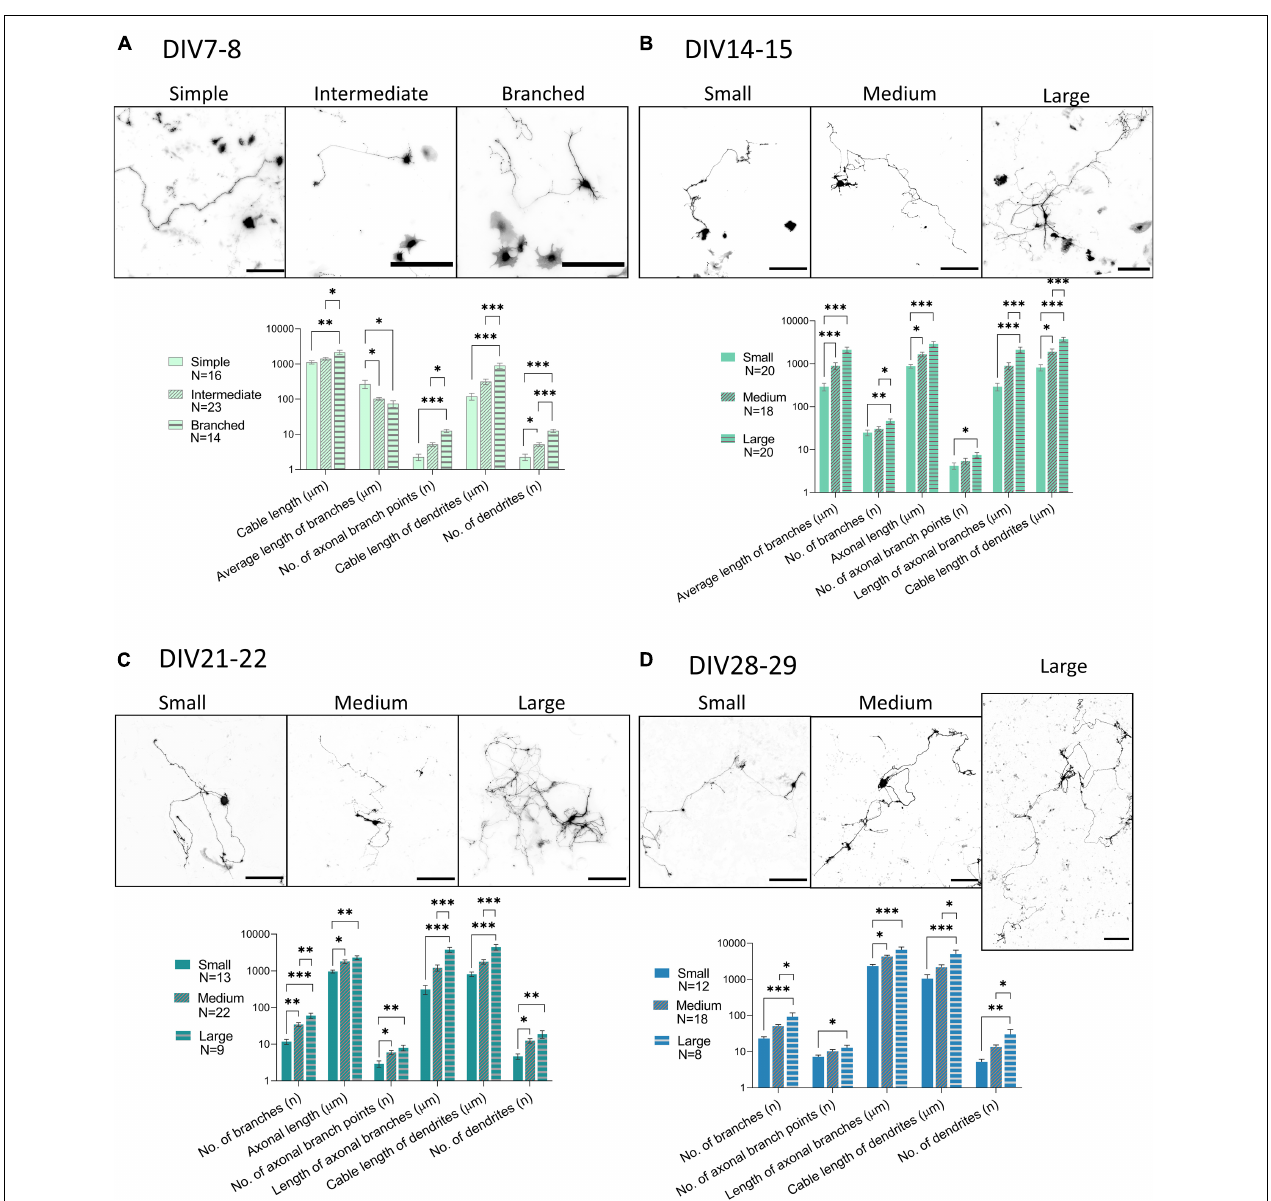
FIGURE 7 | Morphological groups of neurons transfected with GFP (black) during various days in vitro (DIV), DIV7-8 (A) , DIV14-15 (B) , DIV21-22 (C) , DIV28-29 (D) . While DIV7 neurons were successfully categorized according to the number of processes into simple, intermediate, and branched, from DIV14 onward, the length of processes was found to be a better parameter for segregating morphologies into small, medium, and large. Scale bars: 200 µ m. One-way ANOVA with Turkey’s post hoc test was used for analyzing the difference between morphological groups. Data are presented as means + SEM of N number of cells from 3 biological replicates; ∗ p < 0.05, ∗∗ p < 0.01, ∗∗∗ p <